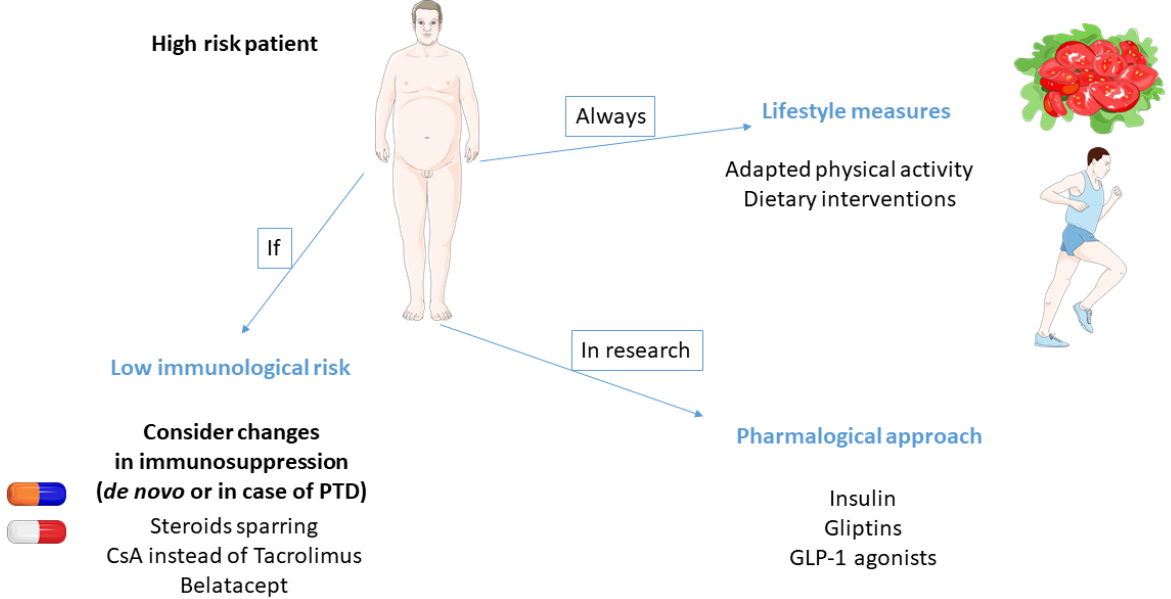
Figure 2. Summarized prevention strategies in post-transplant